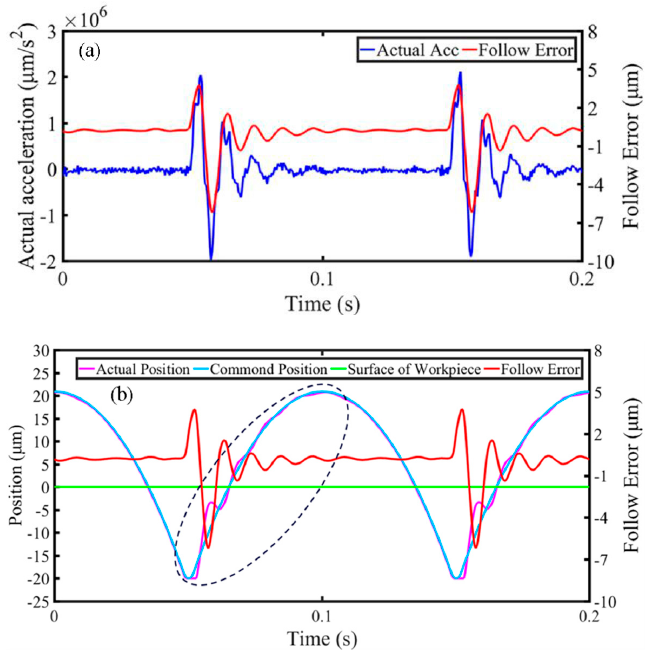
Figure 9. The collected real-time kinematic information of the cutting axis. ( a ) Actual acceleration and follow error; ( b ) Follow error, actual, and command position.